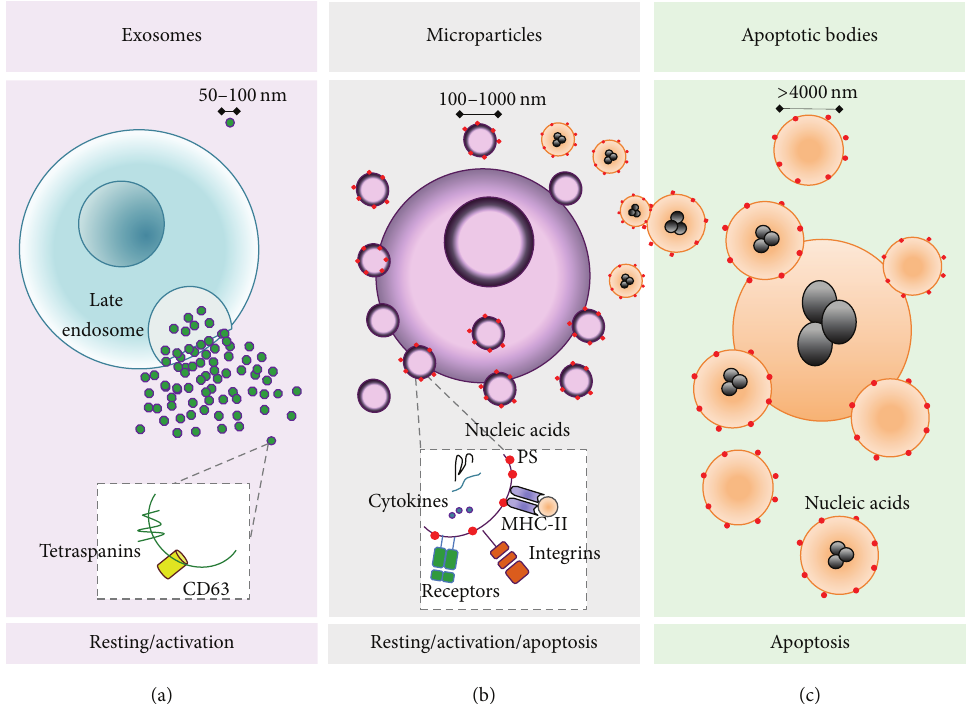
Figure 1: The main characteristics of secreted vesicles. (a) Cells under basal or activated states release vesicles from internal compartments such as multivesicular endosomes, also called late endosomes. Fusion among the endosomal membranes and the cell membrane leads to secretion of intravesicular bodies, which once released are called exosomes and may contain components such as TSG101 and endocytic tetraspanins (CD9 and CD63). (b) Activated cells may secrete vesicles by direct budding of the plasma membrane, called MPs, that contain various receptors, integrins, selectins, cytokines, and nucleic acids. These molecules can be located inside or on the surface of the MPs; however, a cell at rest or in response to physiological stimuli can also produce MPs, but upon activation it produces increased amounts. (c) Apoptotic cell death leads to the formation of apoptotic bodies and MPs, which may contain histones and nucleic acids. The aminophospholipid phosphatidylserine (PS) is exposed on the outer face of the cell membrane during apoptosis. MPs that express PS on their surface can also be generated by cleavage processes from apoptotic bodies. Table 1: Characteristics and properties of the main secreted